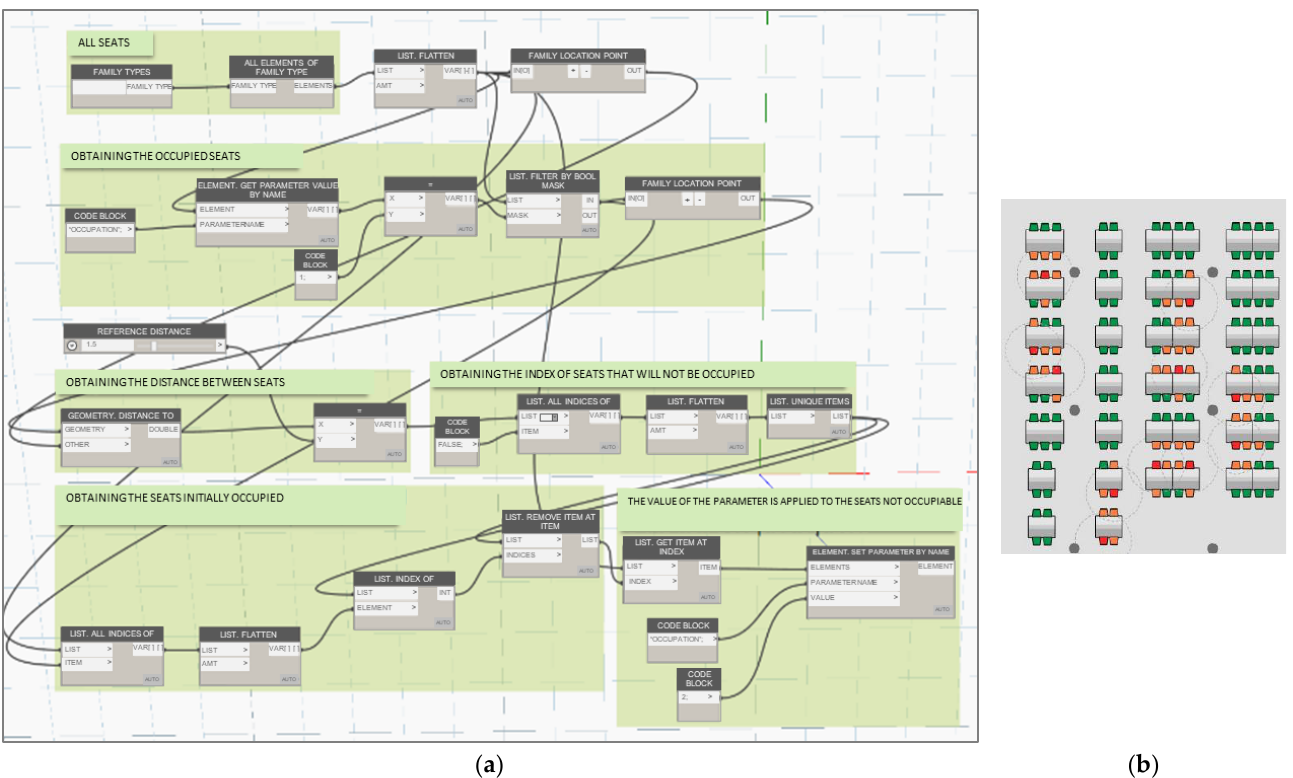
Figure 11. ( a ) Example of programming with Dynamo to simulate the optimal occupancy of seats complying with the social distancing regulations during the pandemic and ( b ) floor plan view of the occupancy status complying with the programmed distance restriction between users, indicated by 1.5-m radius circumferences over the occupied seats.